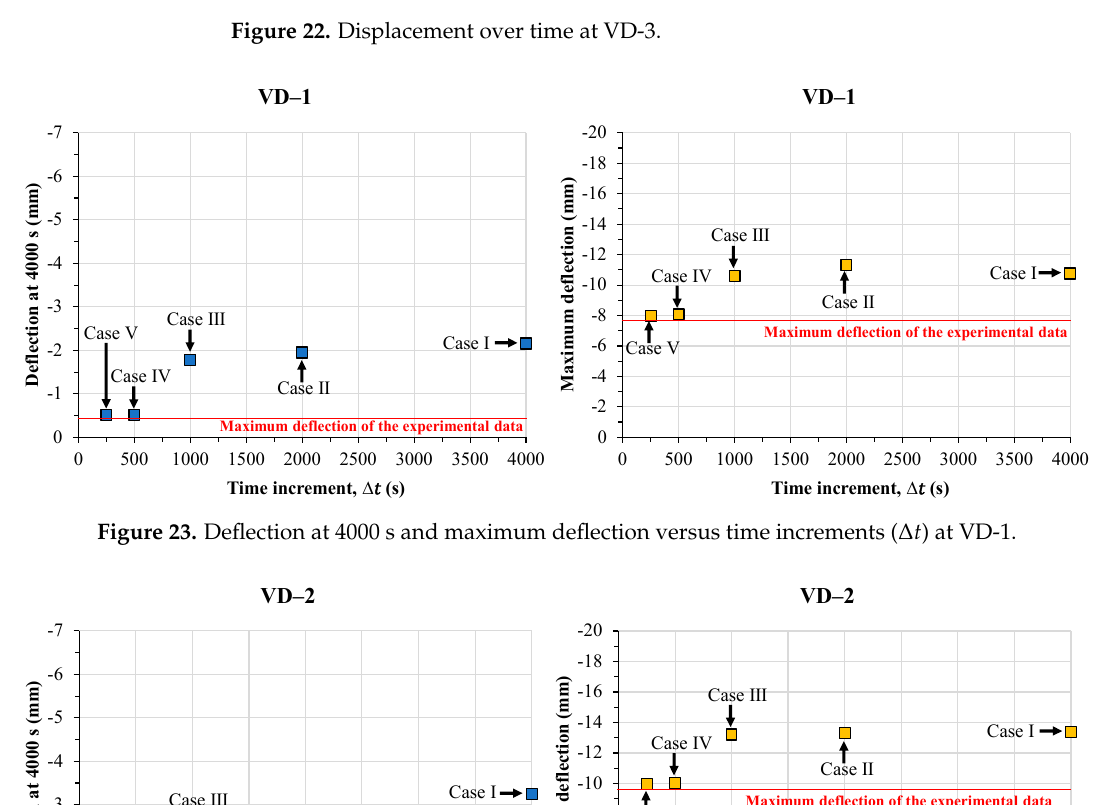
Figure 25. Deflection at 4000 s and maximum deflection versus time increments ( ∆𝑡 ) at VD-3. Figure 26. Statistical analysis results of two-way FSI for deflection versus time increments ( ∆𝑡 ) at VD-1.